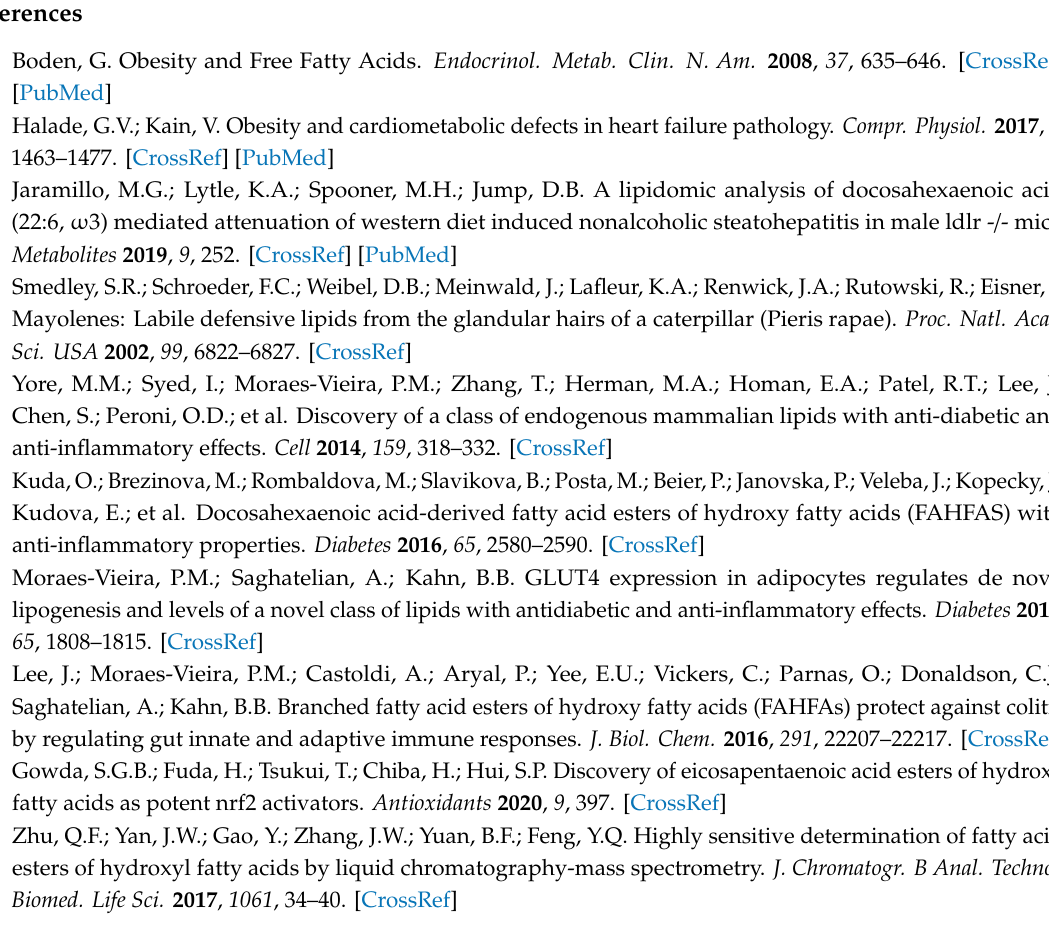
Figure S1: Extracted ion chromatogram and mass spectra of internal standard oleic acid-d9, Figure S2: Extracted ion chromatograms (A) SFAHFAs in blank (B) Anticipated oleic acid-d9 esterified hydroxy fatty acid FAHFAs in sample (C) Anticipated oleic acid-d9 esterified hydroxy stearic acid FAHFAs in sample, Figure S3: Total SFAHFAs comparison between colon and cecum